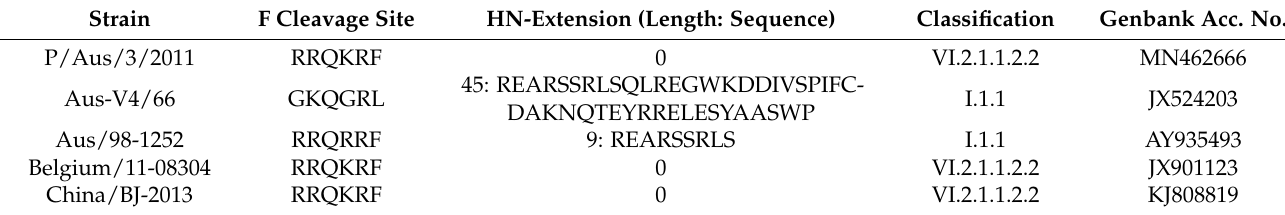
Table 6. Molecular characteristics of P/Aus/3/2011 PPMV-1 compared with closely related PPMV-1 strains and previous NDV isolated from Australia. Strain F Cleavage